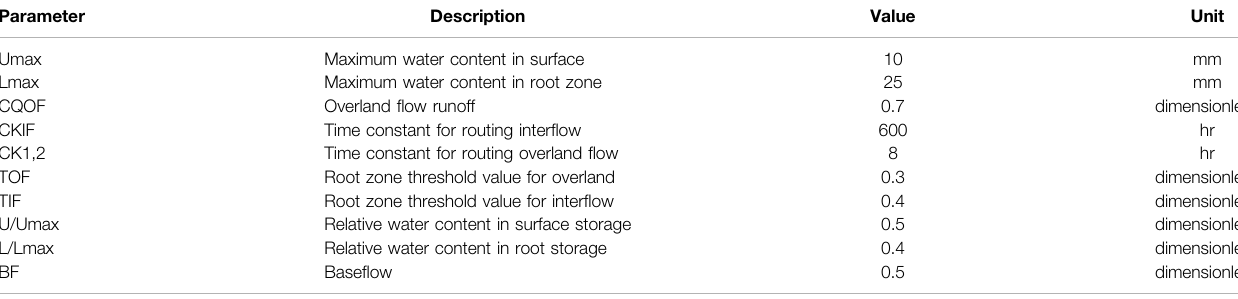
TABLE 2 | Hydrologic submodel parameters and their input values obtained during calibration. Parameter